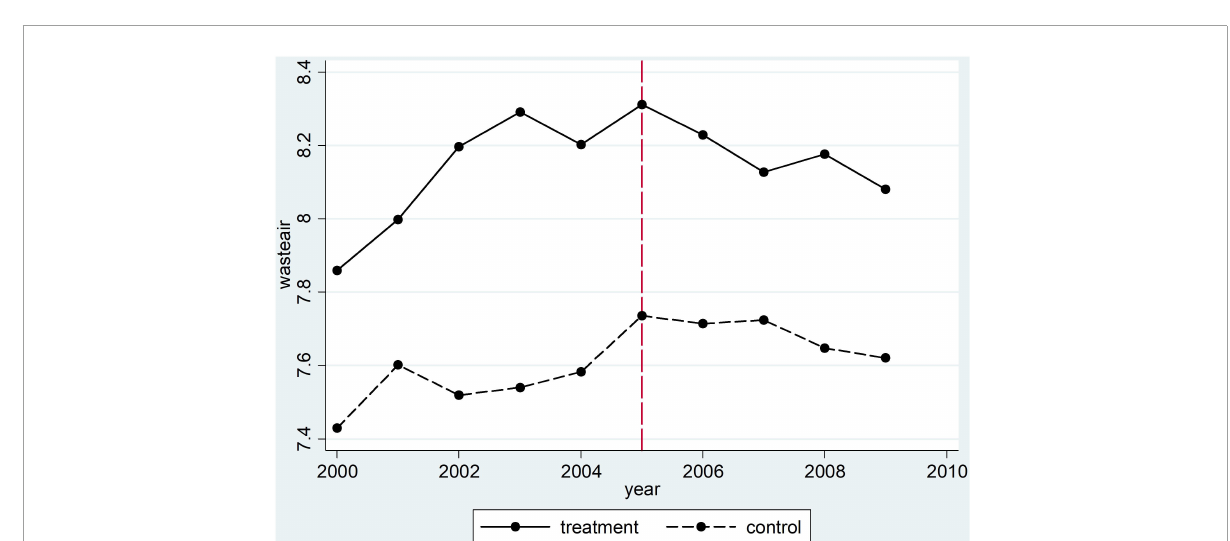
FIGURE1 Parallel trend of wastewater.